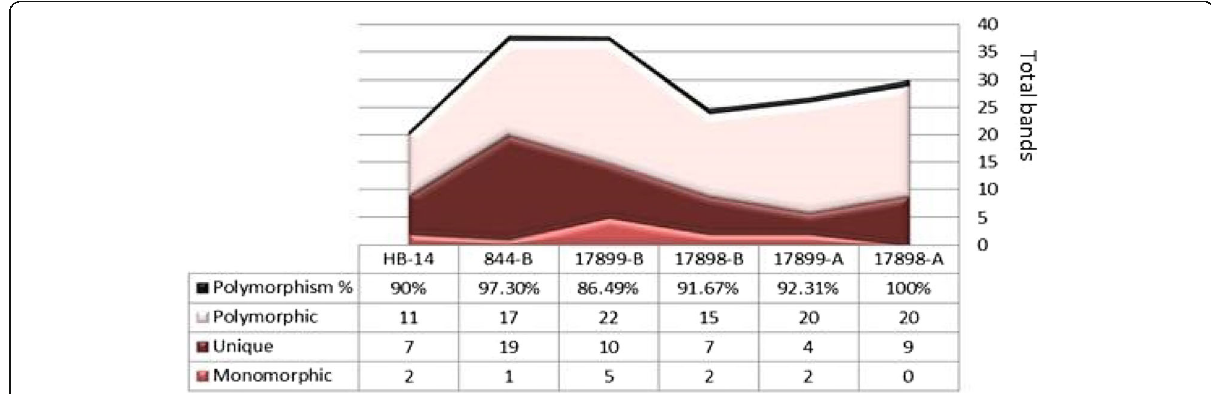
Fig. 2 The relationship between total bands and monomorphic, unique, polymorphic, and polymorphism percentage of six ISSR primers used for the detection of seven wheat